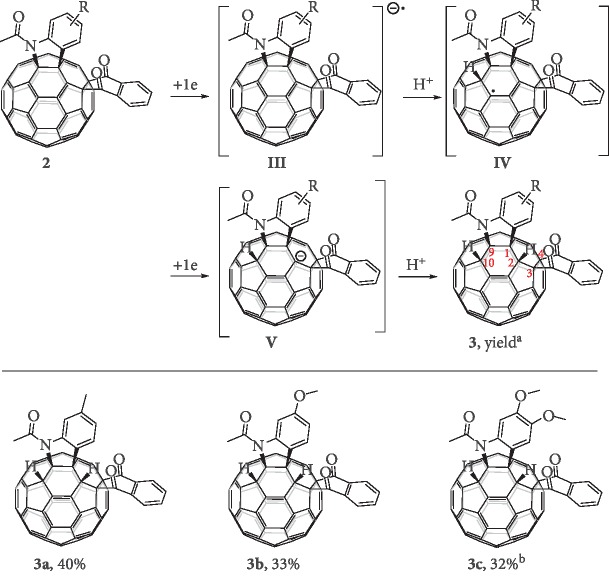
Syntheses of 3a, 3b, and 3c. Unless otherwise specified, all the reactions were performed with 0.01 mmol of 2, 0.01 mmol of TFA, and CPE at –1.20 V, at 25°C under an argon atmosphere. aIsolated yield. bCPE at –1.13 V.